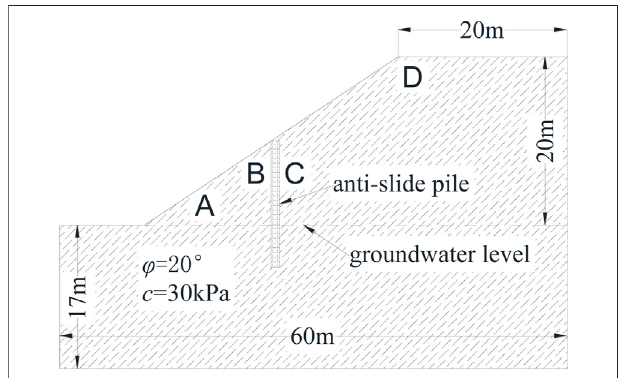
FIGURE 1 | Sketch of the slope